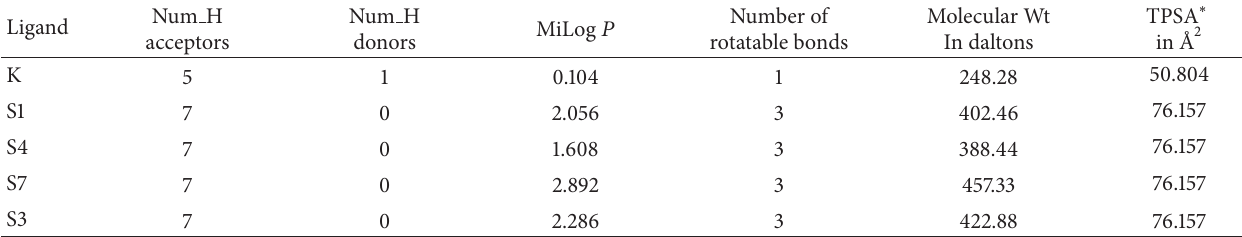
Table 3: Lipinski’s rule of five and ∗ topological polar surface area (TPSA), permeability factor values of derivatives. Num Num H Ligand acceptors